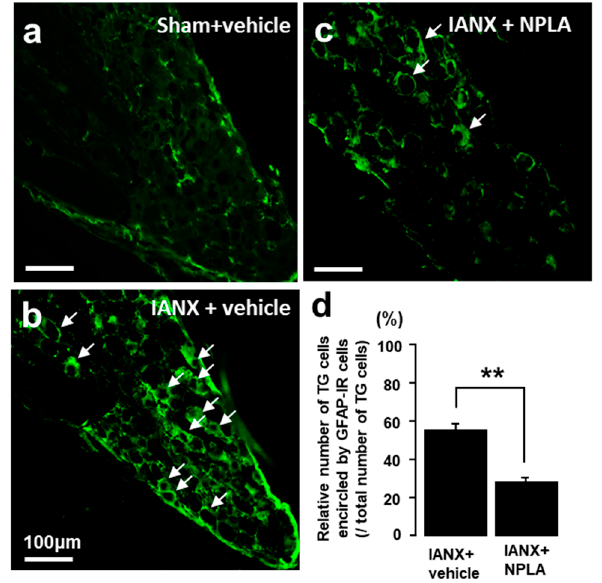
Figure 7. The effect of nNOS inhibitor (NPLA) injection on GFAP expression in TG in sham and IANX rats on day 3. ( a ): GFAP-IR cells in sham + vehicle ( b ) or IANX + NPLA rats ( c ). ( d ): Relative number of TG cells encircled by GFAP-IR cells in INAX + vehicle, IANX + NPLA and sham + vehicle rats. The arrows indicate GFAP-IR cells. ** p < 0.01, n = 5 in each group.